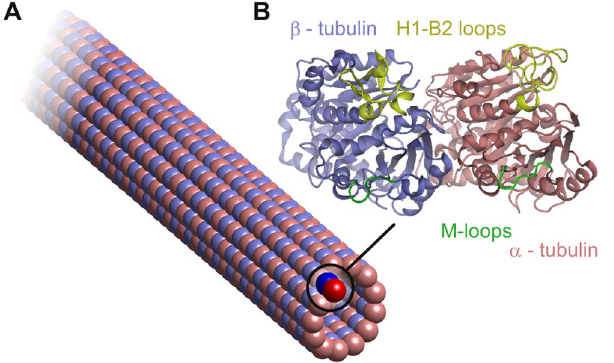
Figure 1. A schematic depiction of the structure of a microtubule with a 13:3 B lattice ( A ) and the secondary protein structure of an α - β tubulin dimer ( B ).